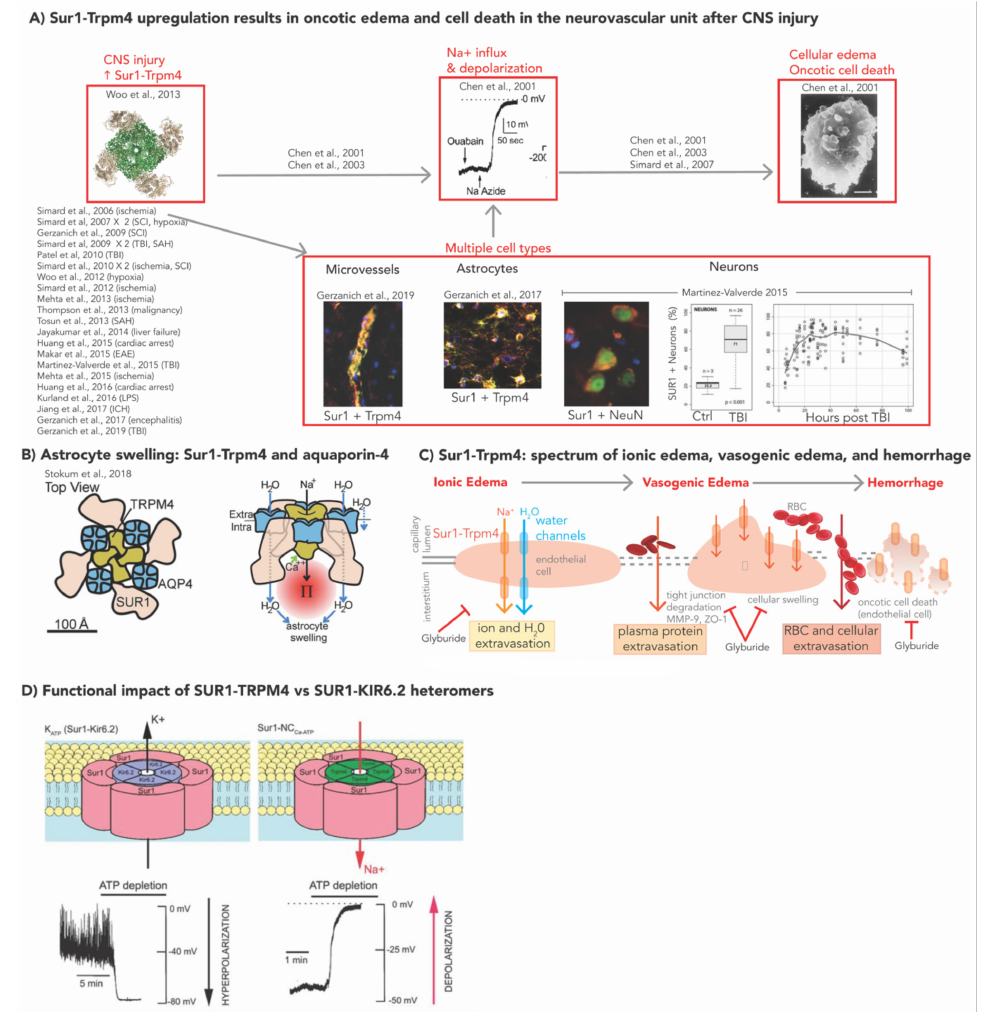
Figure 1. Overview of SUR1-TRPM4 and cerebral edema in central nervous system